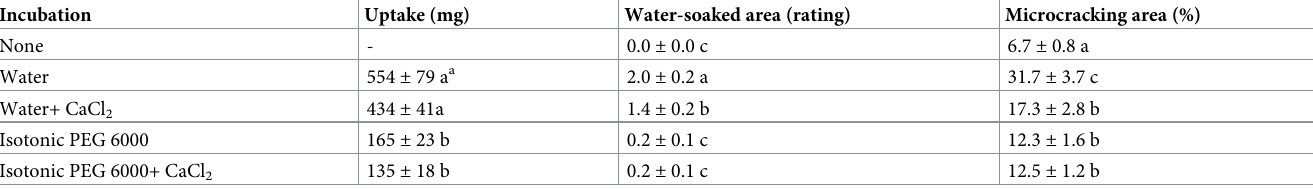
Table 6. Effect of CaCl 2 (10 mM) on water uptake, water soaking and microcracking of the cuticle of ‘Florentina’